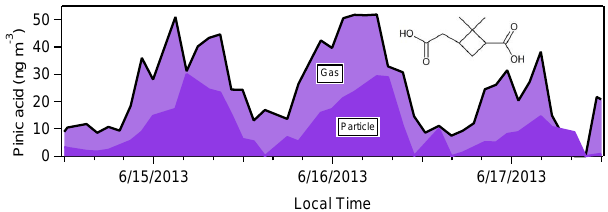
Figure 6. Sample final data of pinic acid, a known tracer for the ox- idation of α -pinene, a common biogenically emitted monoterpene. Gas-phase concentration (light purple) is measured as the difference between total concentration (black line) and particle-phase concen- tration (dark